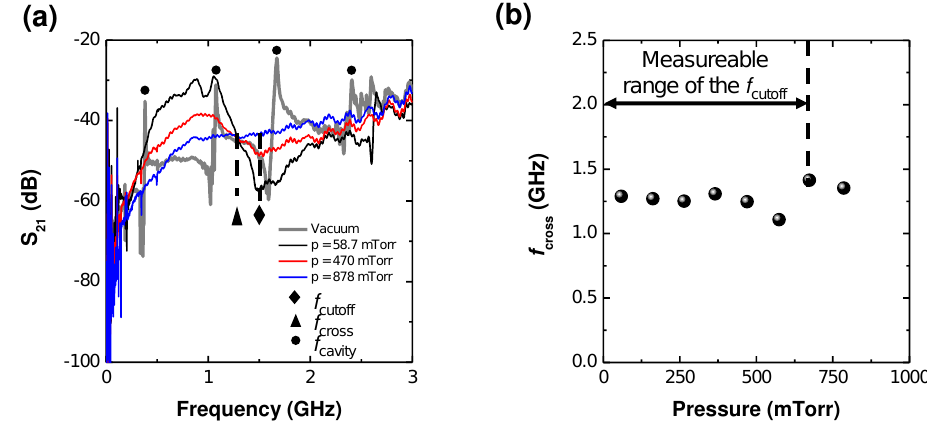
Figure 4. ( a ) Experimental S 21 spectra at various pressures and vacuum with a cutoff frequency ( f cutoff ) of 1.5 GHz. ( b ) Measured f cross at constant f cutoff over